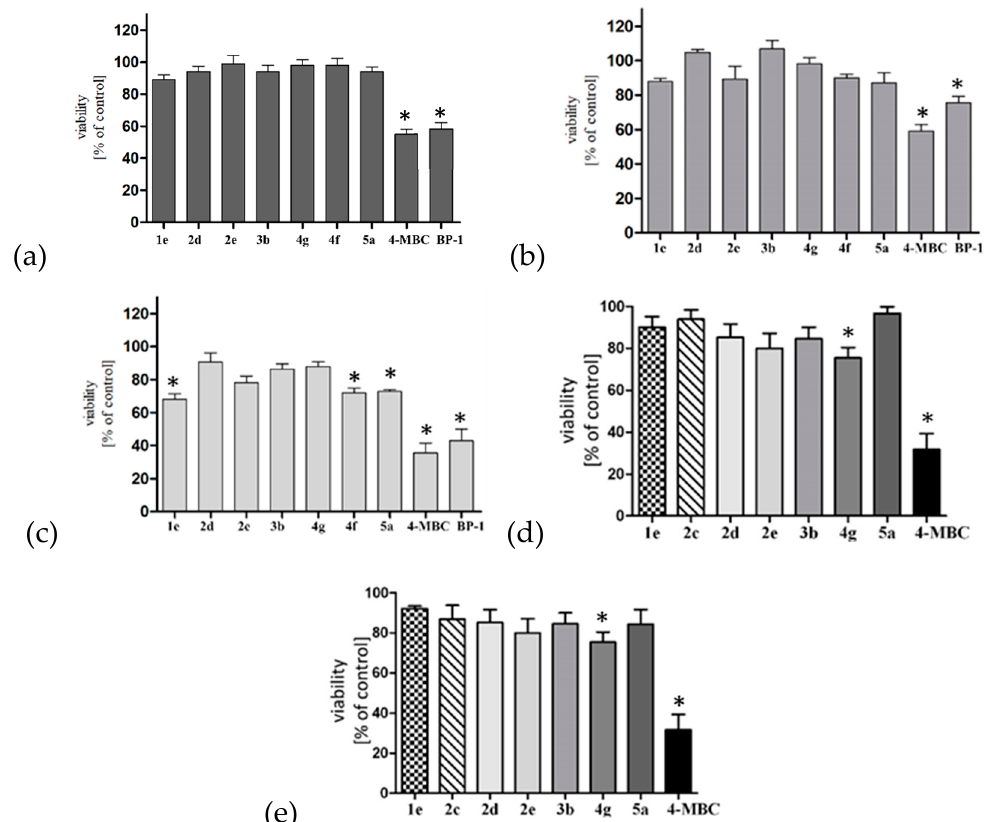
Figure 6. Viability of human keratinocytes HaCaT ( a ), human skin fibroblast (BJ) ( b ) cell lines, human primary dermal melanocytes ( c ), HepG2 cells ( d ) and SH-SY5Y cells ( e ) incubated in the presence of compounds at 50 µ M for 24 hours. Cell viability was determined using MTT assay. Each experiment was repeated in triplicate. Graphs represent the number of viable cells expressed as percent of control (cells not treated with compounds) ± SEM ( p <